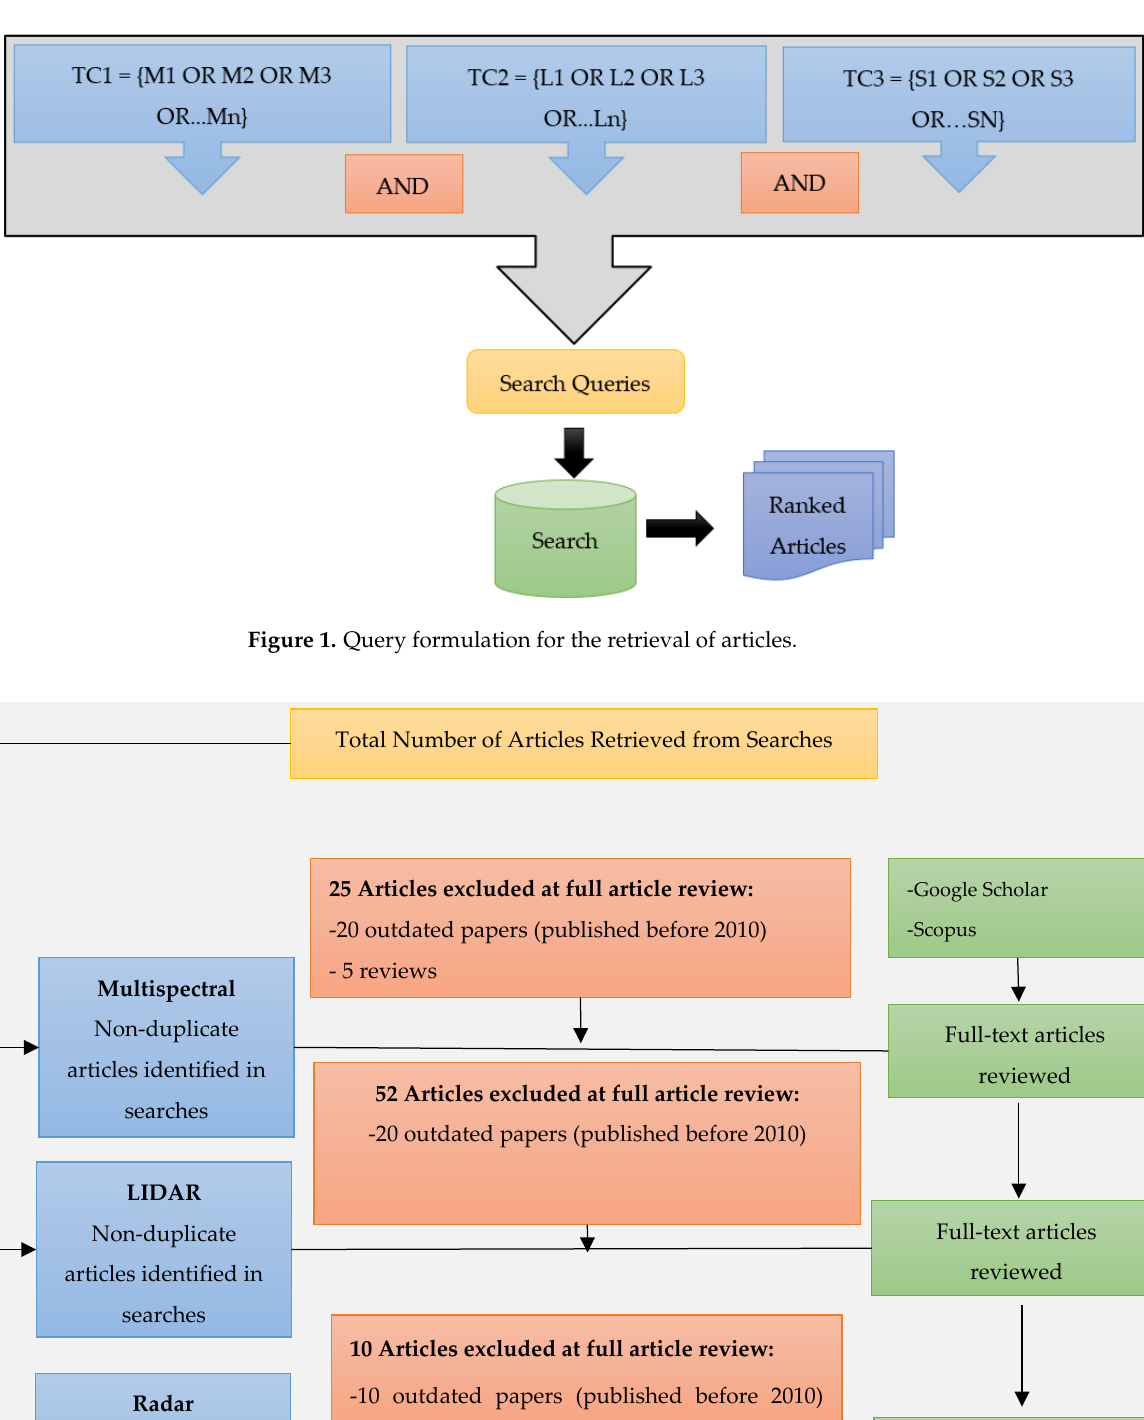
Figure 3. Year-wise distribution of articles from each category. After the first phase based on article retrieval, the articles were passed through a screening phase to further narrow down the selection criteria. Four assessment criteria were defined to evaluate the articles: 0